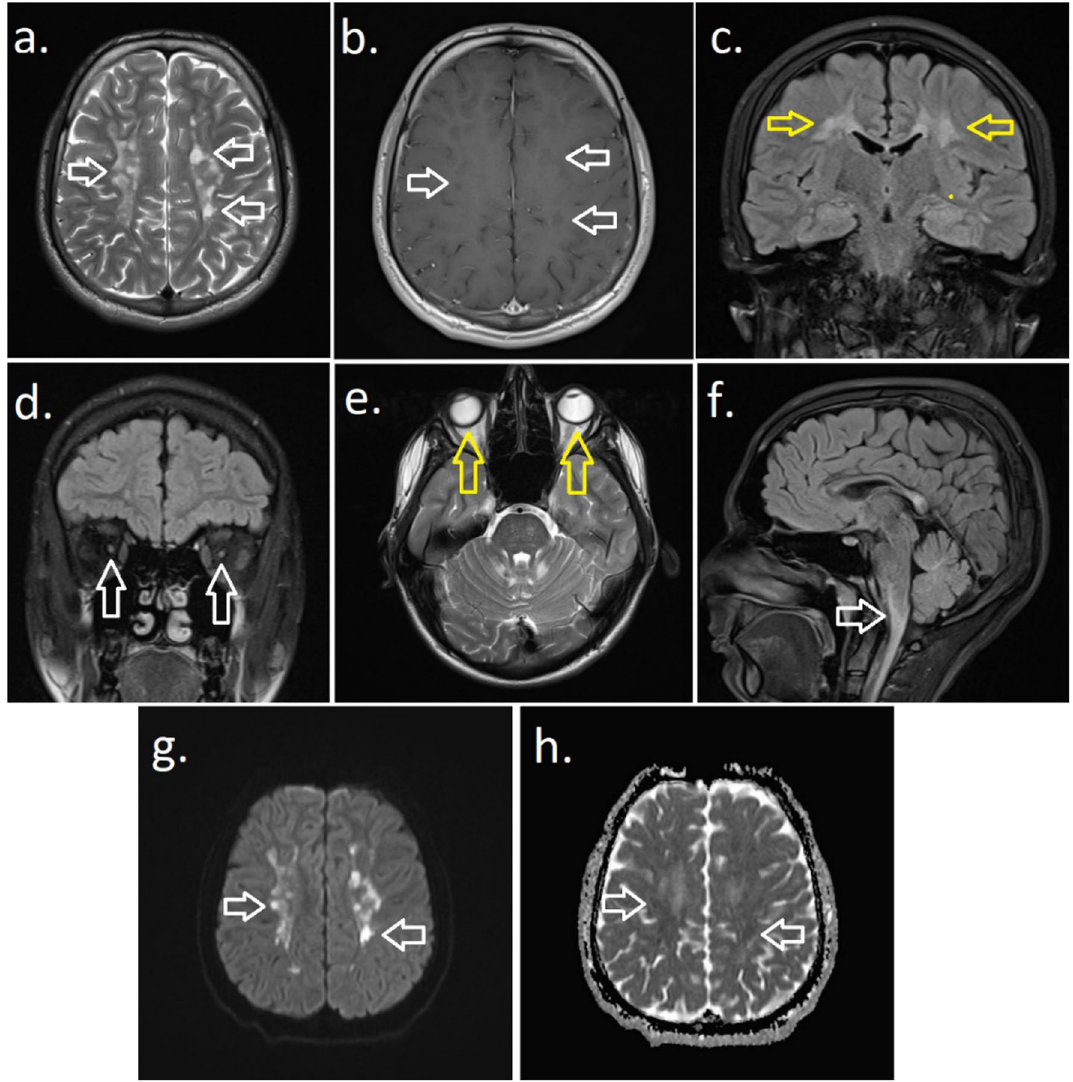
Fig. 2 a T2 axial MR image: hyperintensity at periventricular white matter (white arrows), b contrast-enhanced T1 axial MR image: no contrast enhancement is seen at the same white matter lesions (white arrows), c coronal FLAIR (Fluid-Attenuated Inversion Recovery) MR image: same lesions on periventricular white matter (yellow arrows), d bilateral atrophic optic nerves (white arrows), e bilateral micro-ophthalmia (yellow arrows), f sagittal FLAIR image: atrophy and hyper-intensity on brainstem (white arrow), g diffusion restriction on diffusion-weighted image and h on ADC (apparent diffusion coefficient) map (arrows)